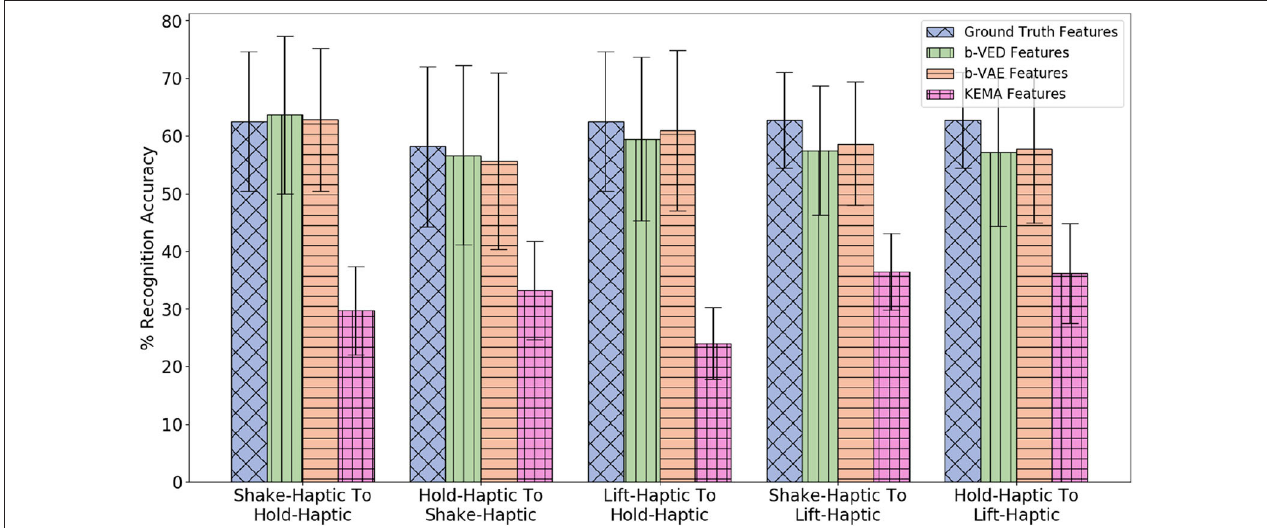
FIGURE 13 | β -VED cross-behavior projections where the Accuracy Delta is minimum and corresponding β -VAE projections and KEMA projections.